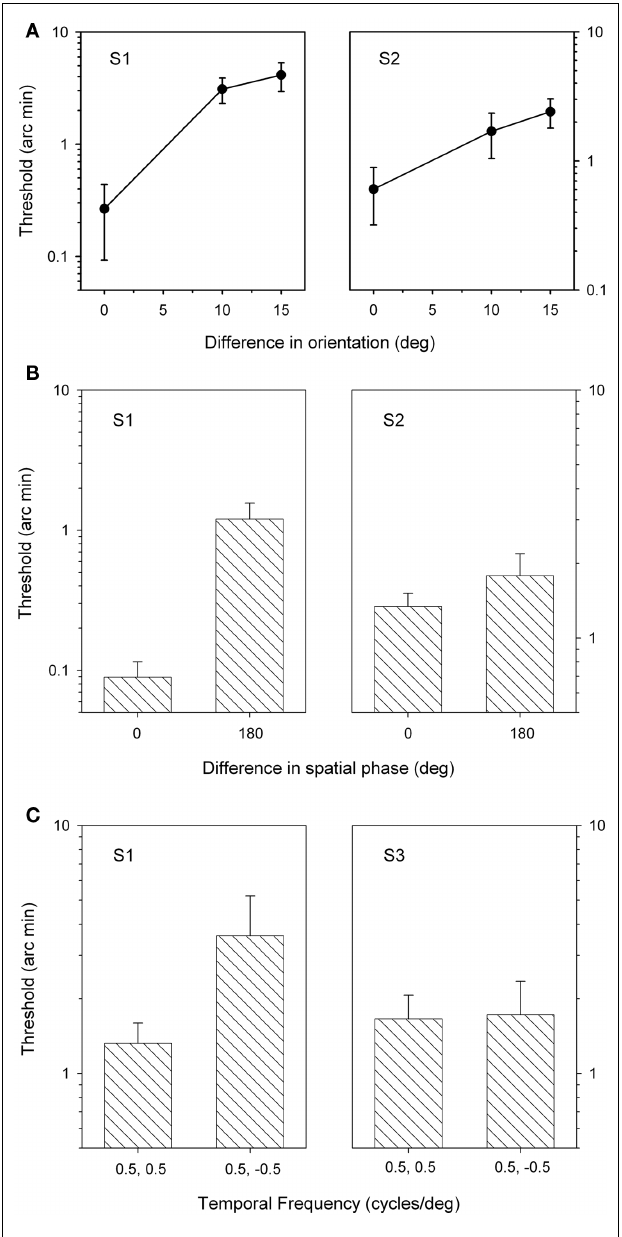
FIGURE 3 | Stereoacuity thresholds for grating patches that varied in orientation (A), spatial phase (B), or direction of motion (C). Bars represent